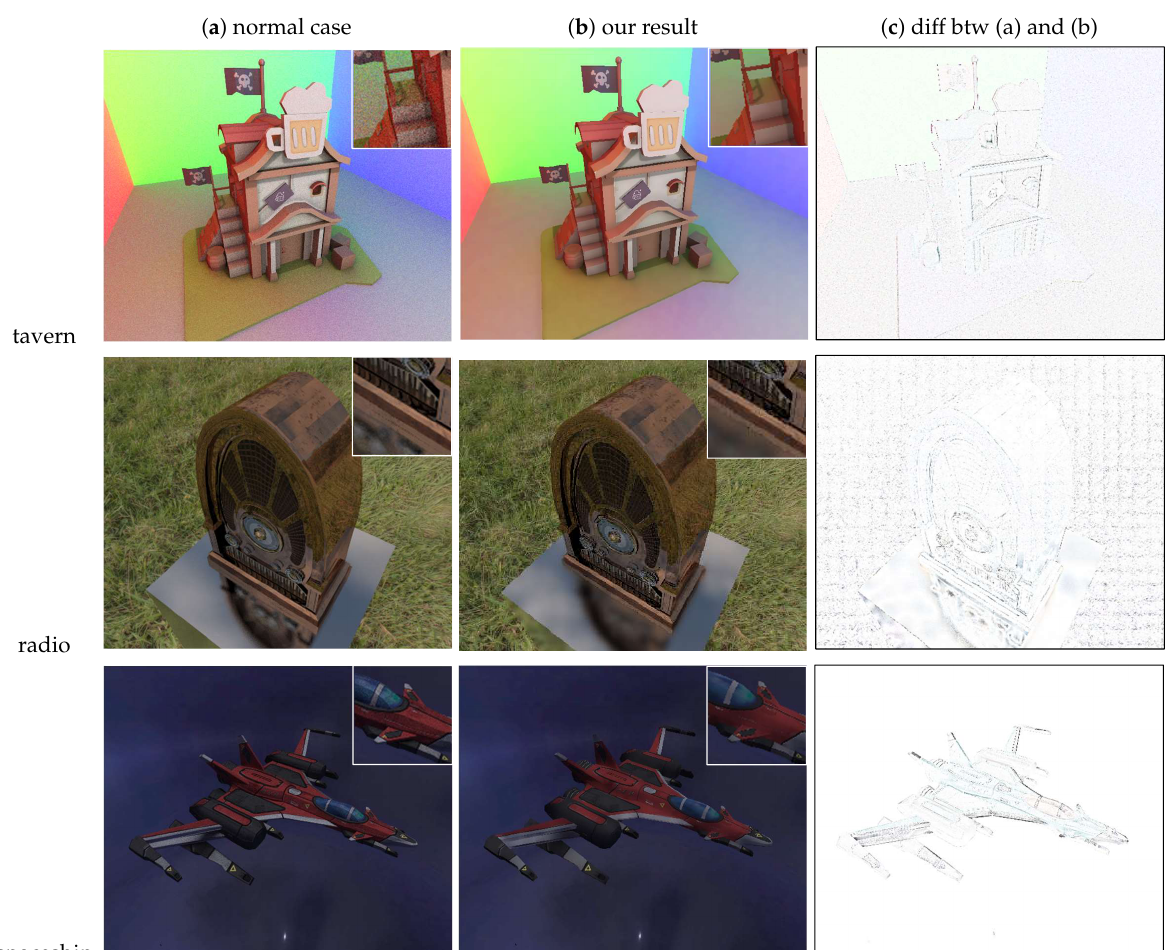
Figure 14. Our rendering results for three different scenes with 2 ray bounce and 100 sample